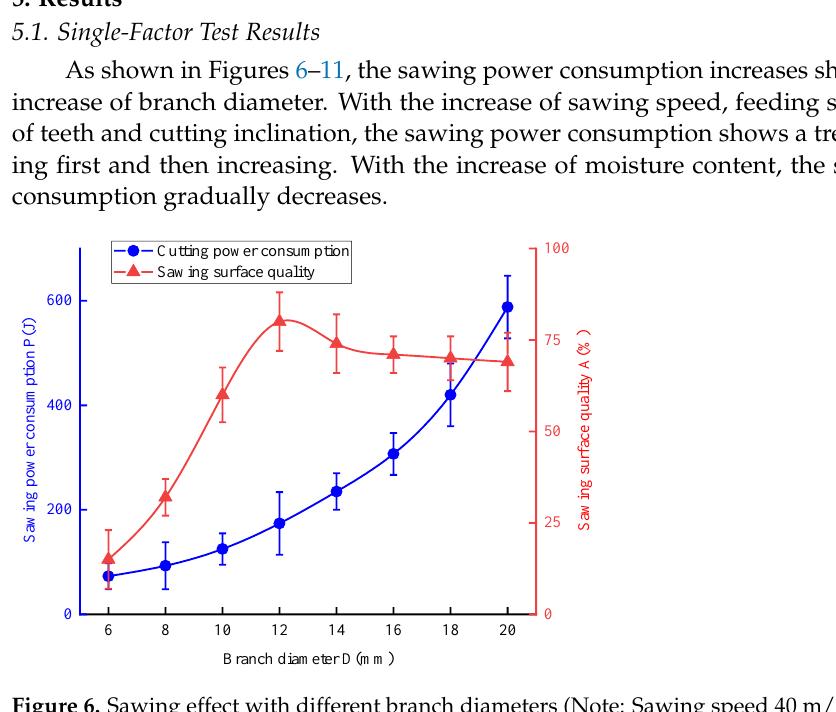
Table 2. Factors and levels of the multi-factor test.